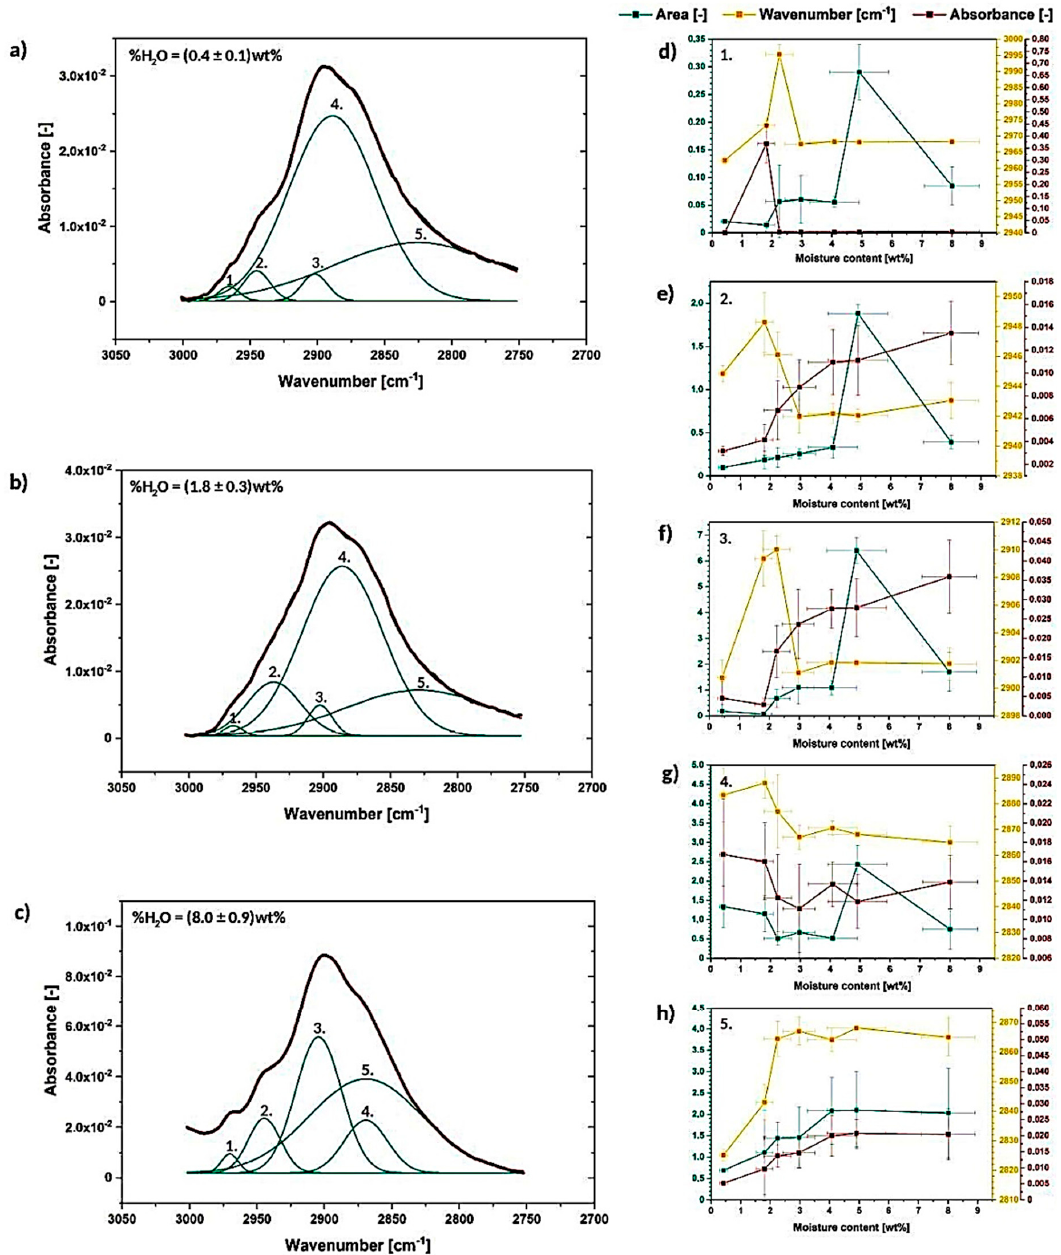
Figure 8. Deconvoluted absorption band between 3000–2750 cm − 1 for the cellulose moisture content of (0.4 ± 0.1) wt% ( a ), (1.8 ± 0.3) wt% ( b ) and (8.0 ± 0.9) wt% ( c ) with graphs illustrating the changes in the deconvoluted peaks area, wavenumber and absorbance ( d – h ).